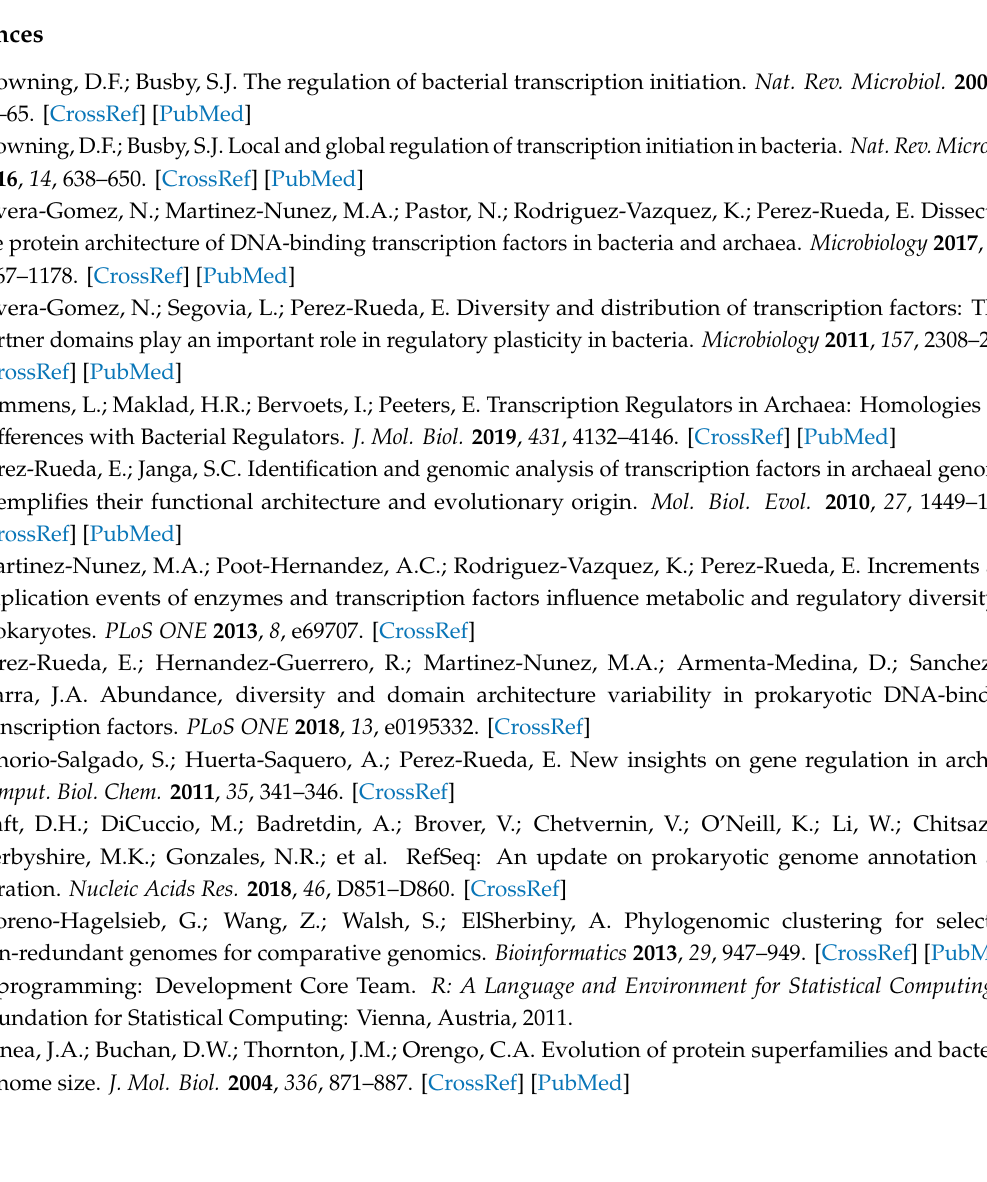
Table S1: Description of all protein families identified in the bacterial and archaea